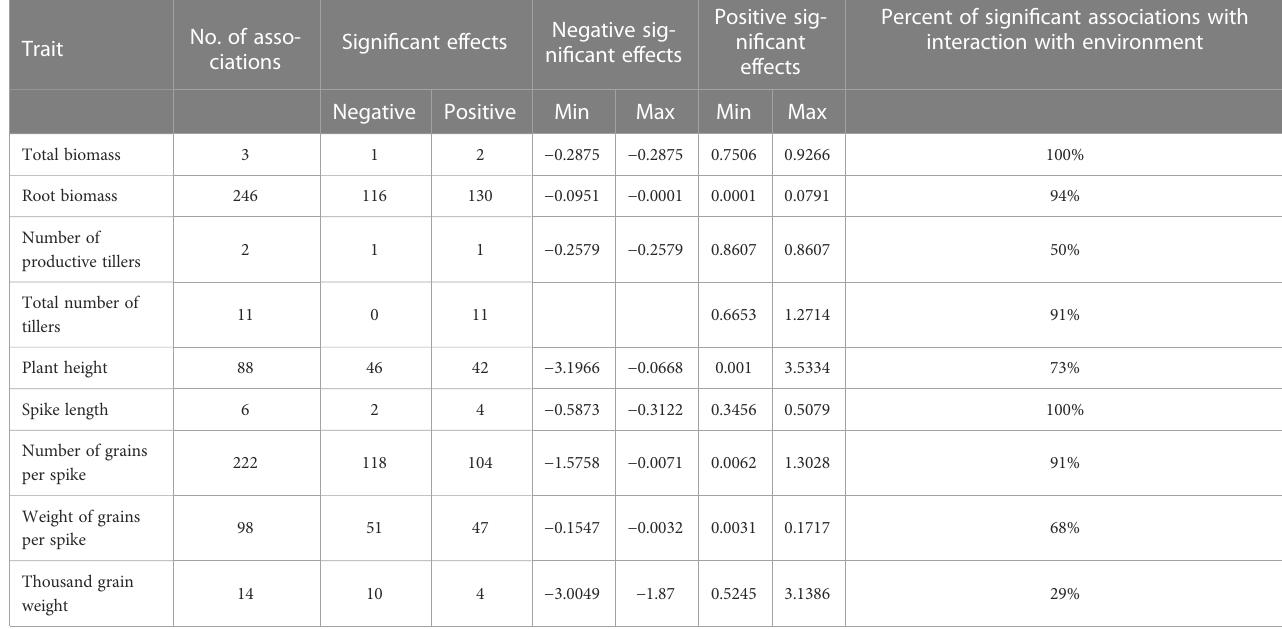
TABLE 5 Characteristics of allelic effects for SNP markers signi fi cantly associated with phenotypic traits.